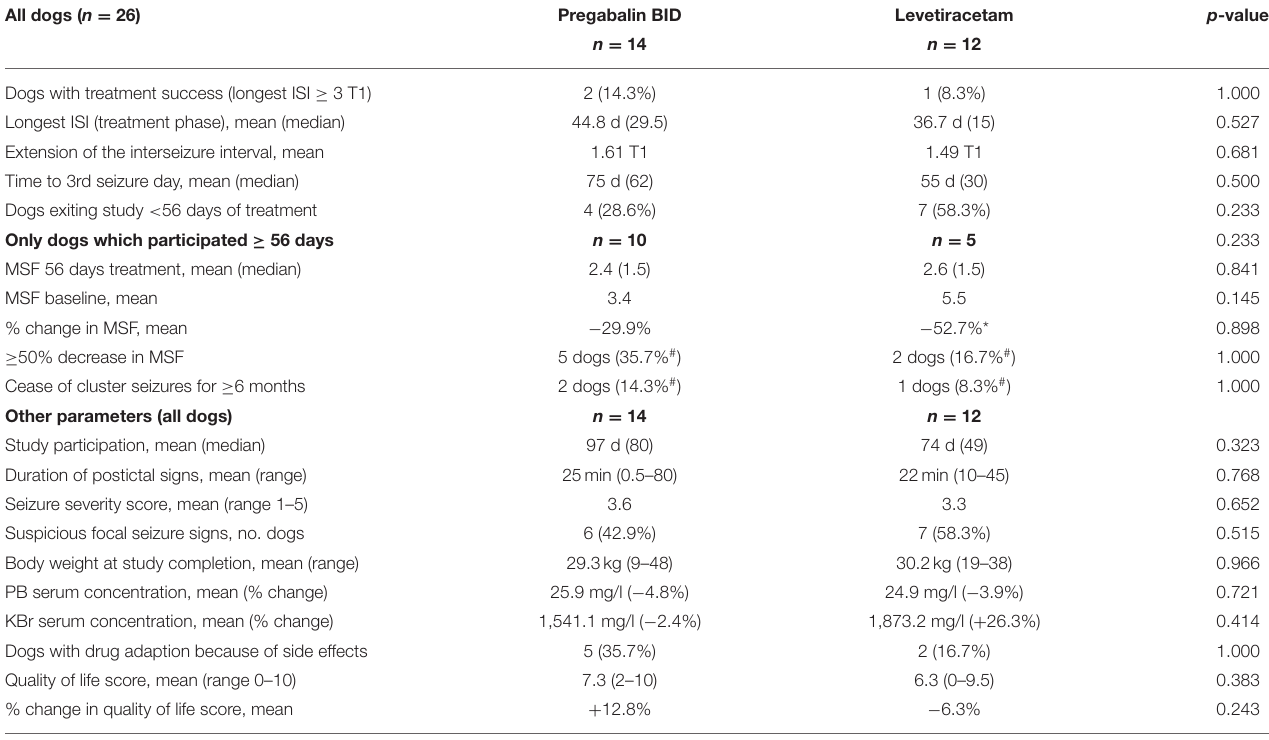
TABLE 3 | Comparative evaluation of efficacy and tolerability of pregabalin add-on vs. dose increase in levetiracetam add-on treatment. All dogs ( n =